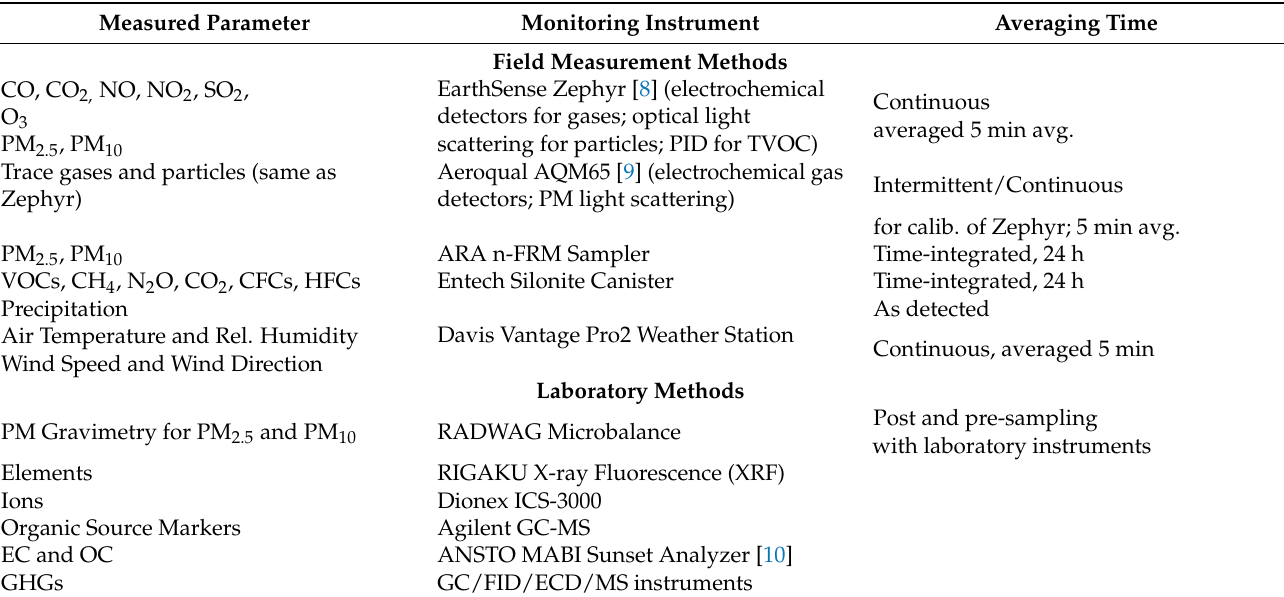
Table 2. Species measurements showing instrumentation and sampling averaging